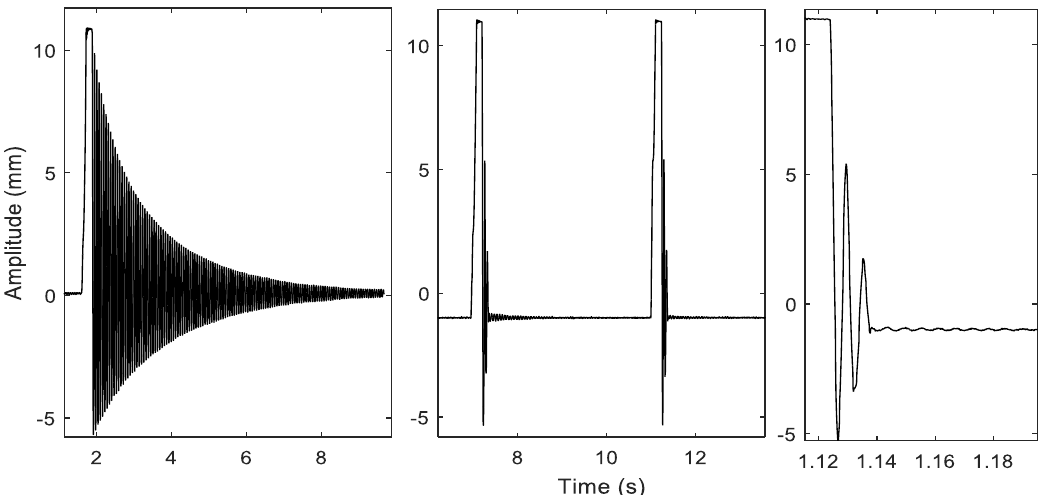
Fig. 6 Closed loop impulse response with the fractional order controller: free impulse response (left), active suppression (center), and zoomed active suppression (right).